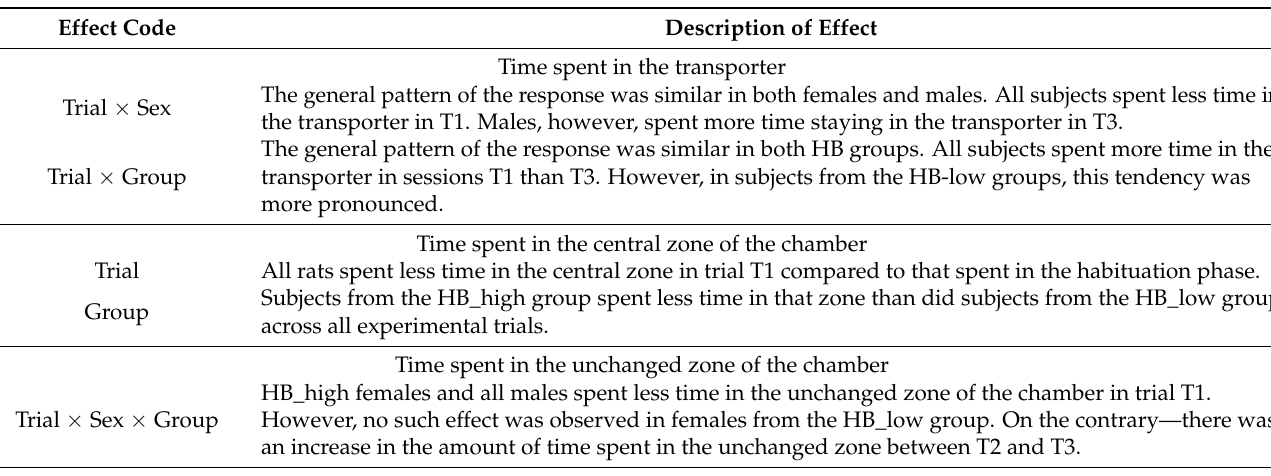
Table 4. Descriptive non-statistical summary of the